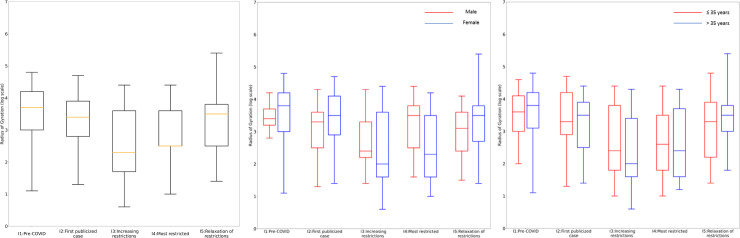
Overall RoG (a), stratified by Sex (b), and stratified by Age (c).